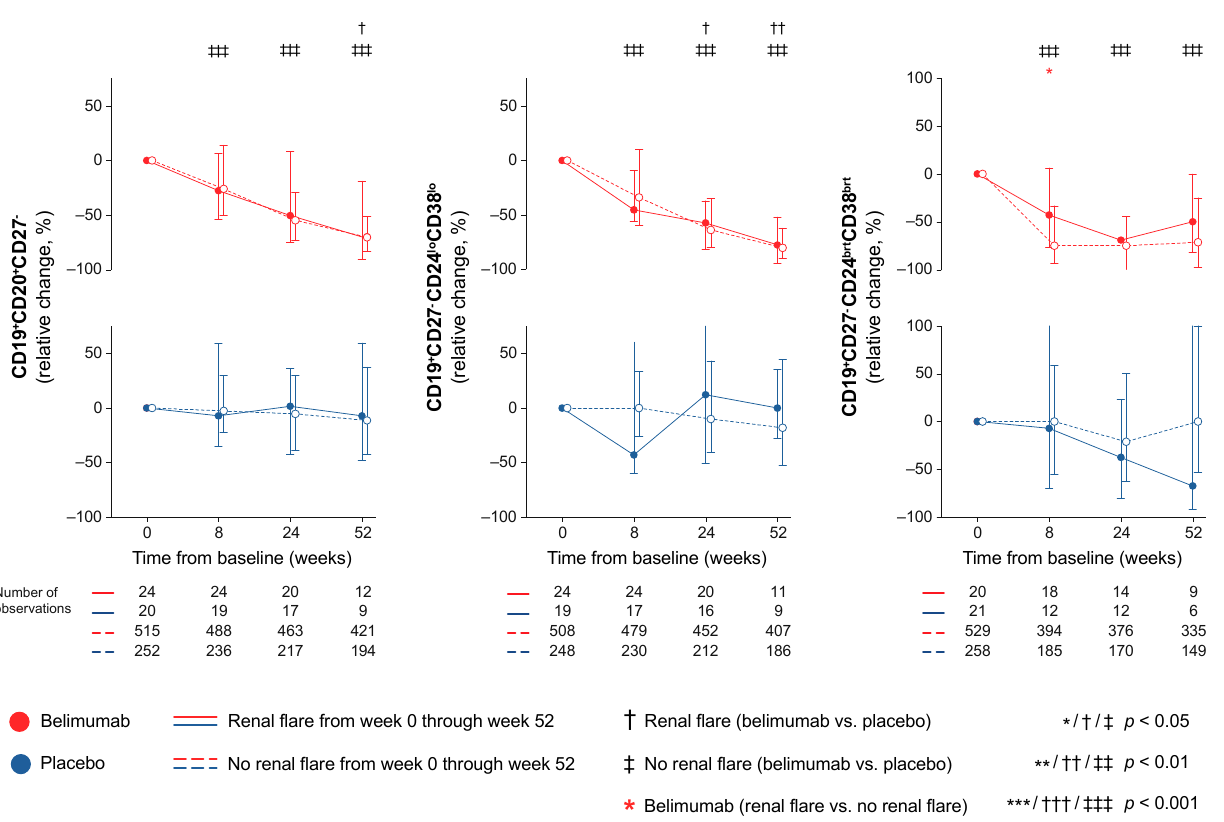
Figure 2. Transitional and naïve B cell alterations in relation to renal flares. The graphs delineate relative to baseline percentage changes in transitional and naïve B cell subsets in patients who developed at least one renal flare during the study period (continuous lines) and patients who did not (dashed lines) in a subanalysis of data from the BLISS-SC trial. Comparisons between patients who flared and patients who did not were conducted for patients with available data, stratified into patients who received non-biological standard therapy plus belimumab (red lines) and patients who received non-biological standard therapy alone (blue lines). P values are derived from non-parametric Mann–Whitney U tests. Whiskers indicate the interquartile range of distributions. The number of patients with available data at each time point is indicated for each patient subgroup.